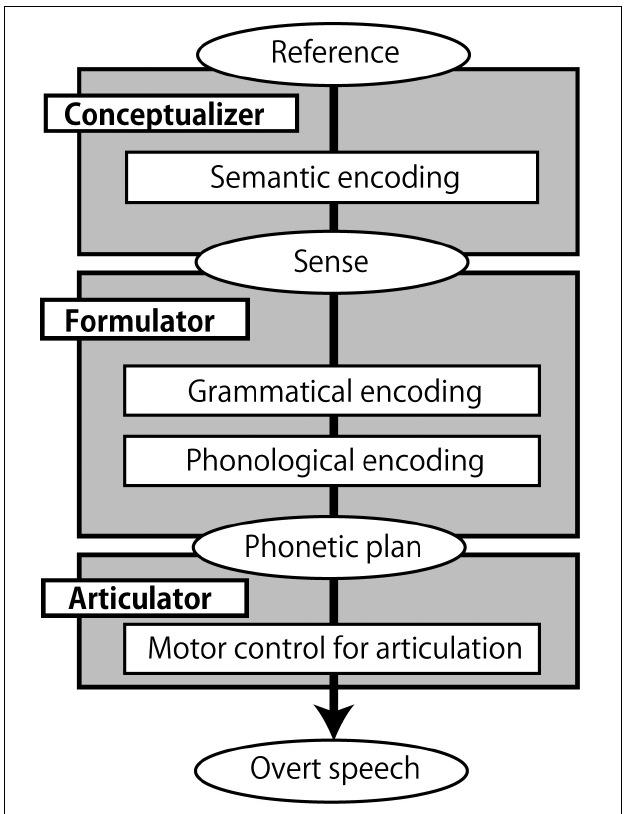
FIGURE 1 | A speech production model. The model is based on (Levelt, 1989; Bock and Levelt, 1994), and (Menenti et al., 2012a). Boxes represent processing components, and ellipses represent products and inputs of the processing